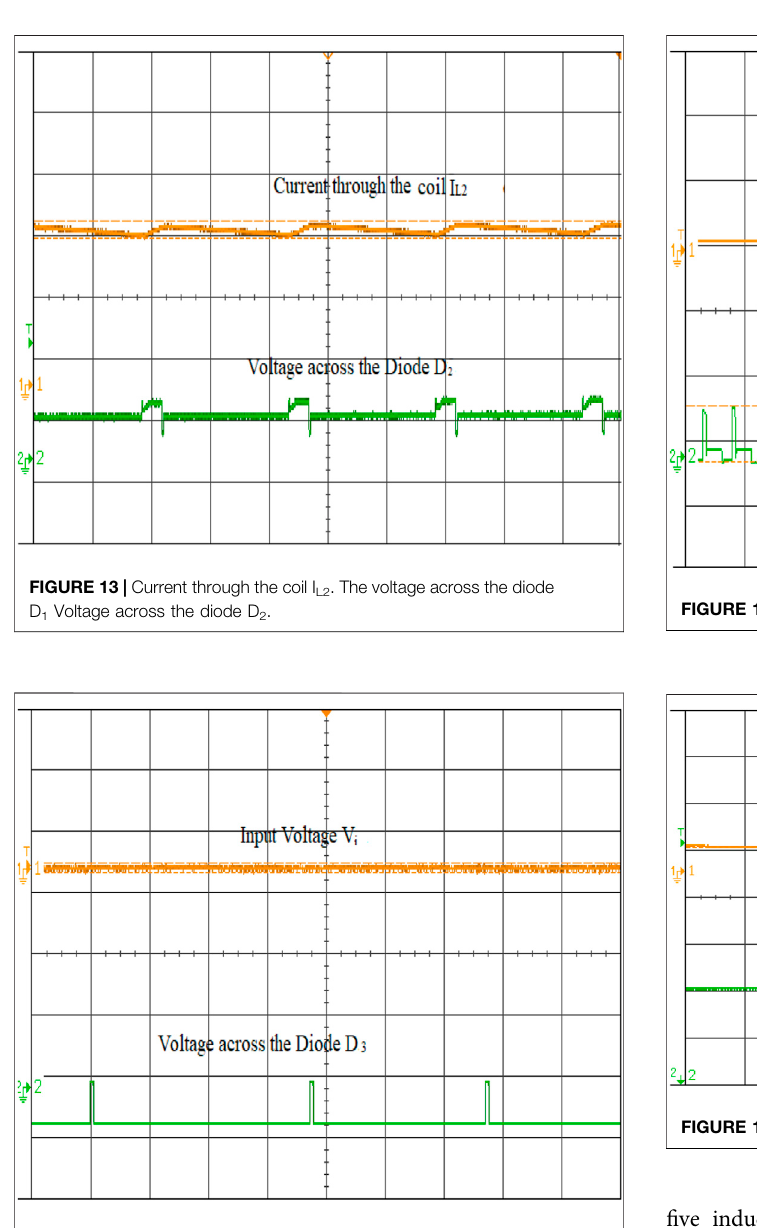
FIGURE 14 | Input Voltage Vin and Diode Voltage D 3 .